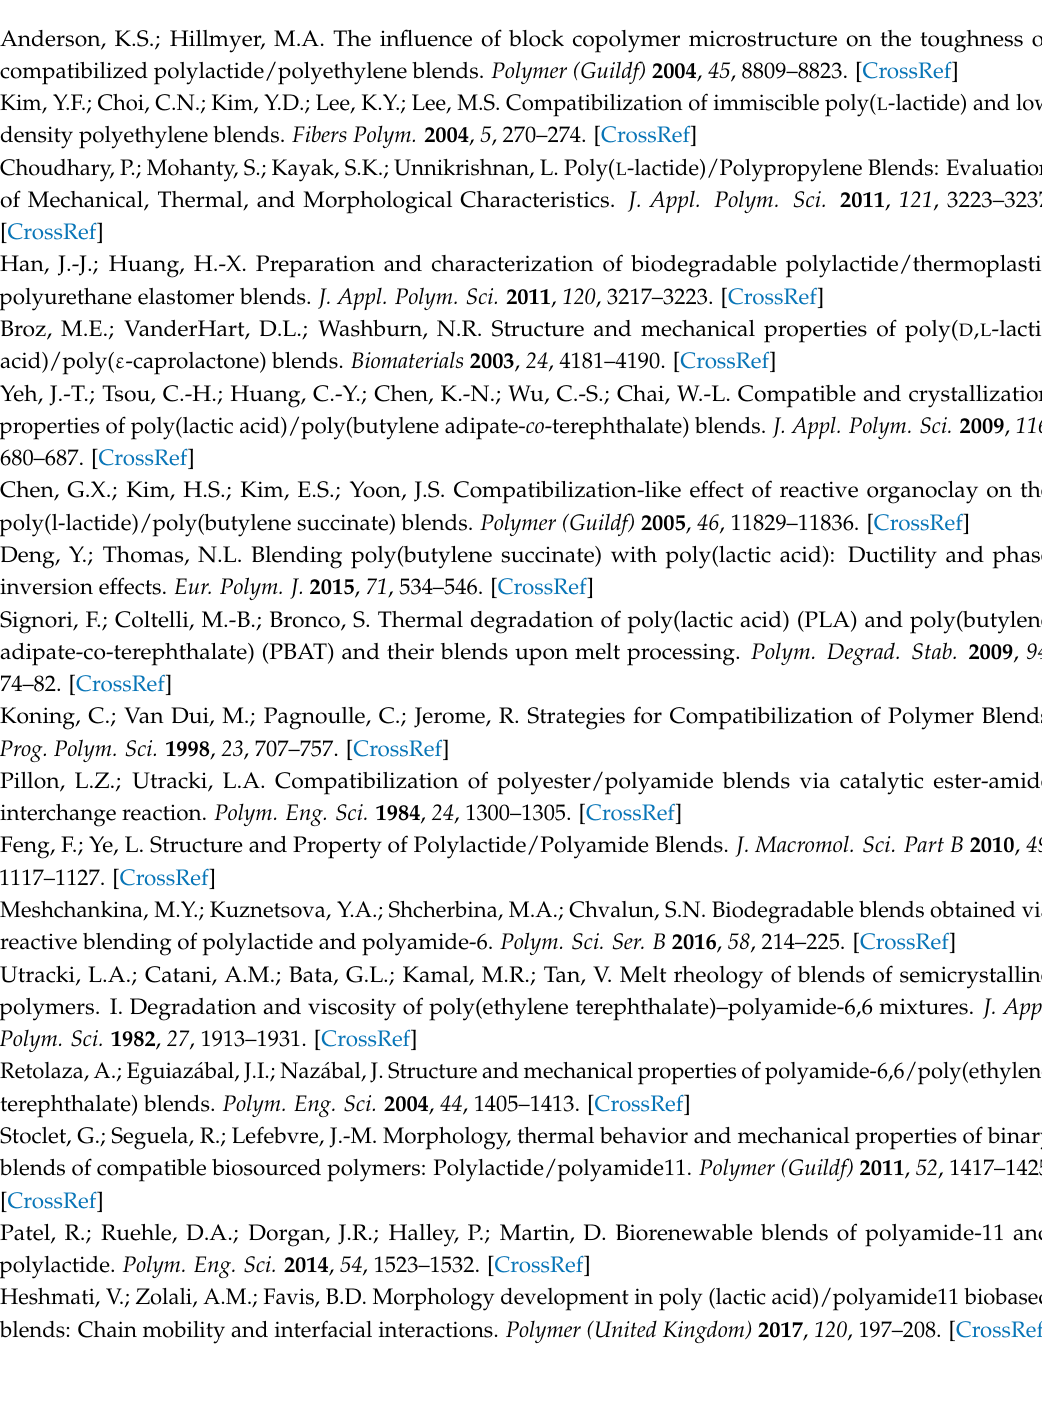
observations MEB of injected dog bone shaped samples, Table S1: Diameters of PA11 dispersed phases extracted from PLA80-Jx blends, Table S2: Mechanical properties of injected neat polymers and PLA80-Jx blends, Table S3: Mechanical properties of FDM printed PLA80-Jx